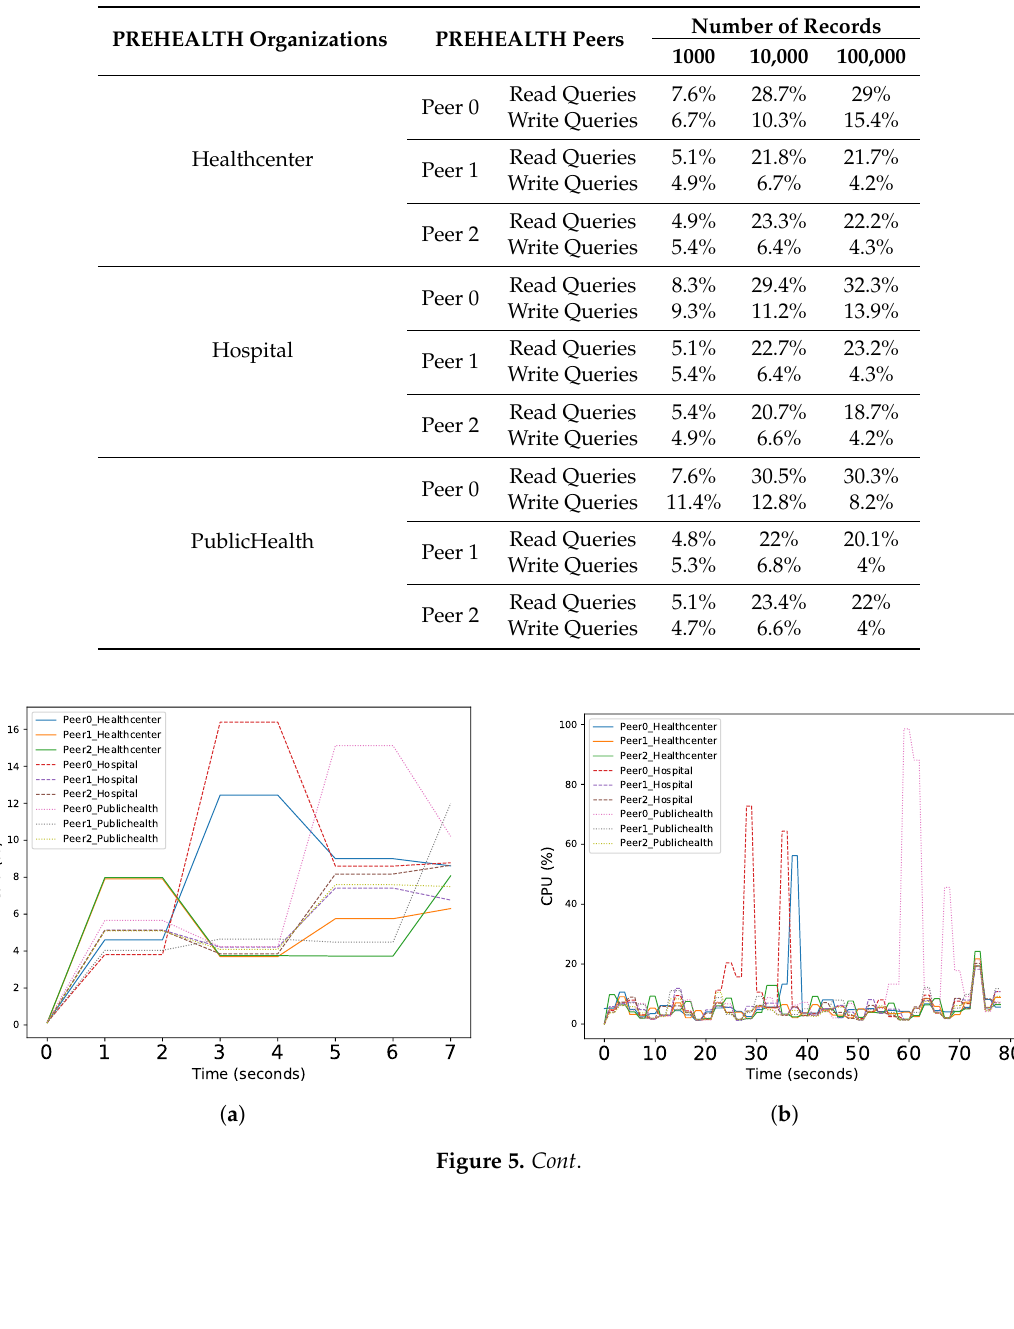
Table 3. Average CPU (%) performance of each blockchain peer per number of electronic health